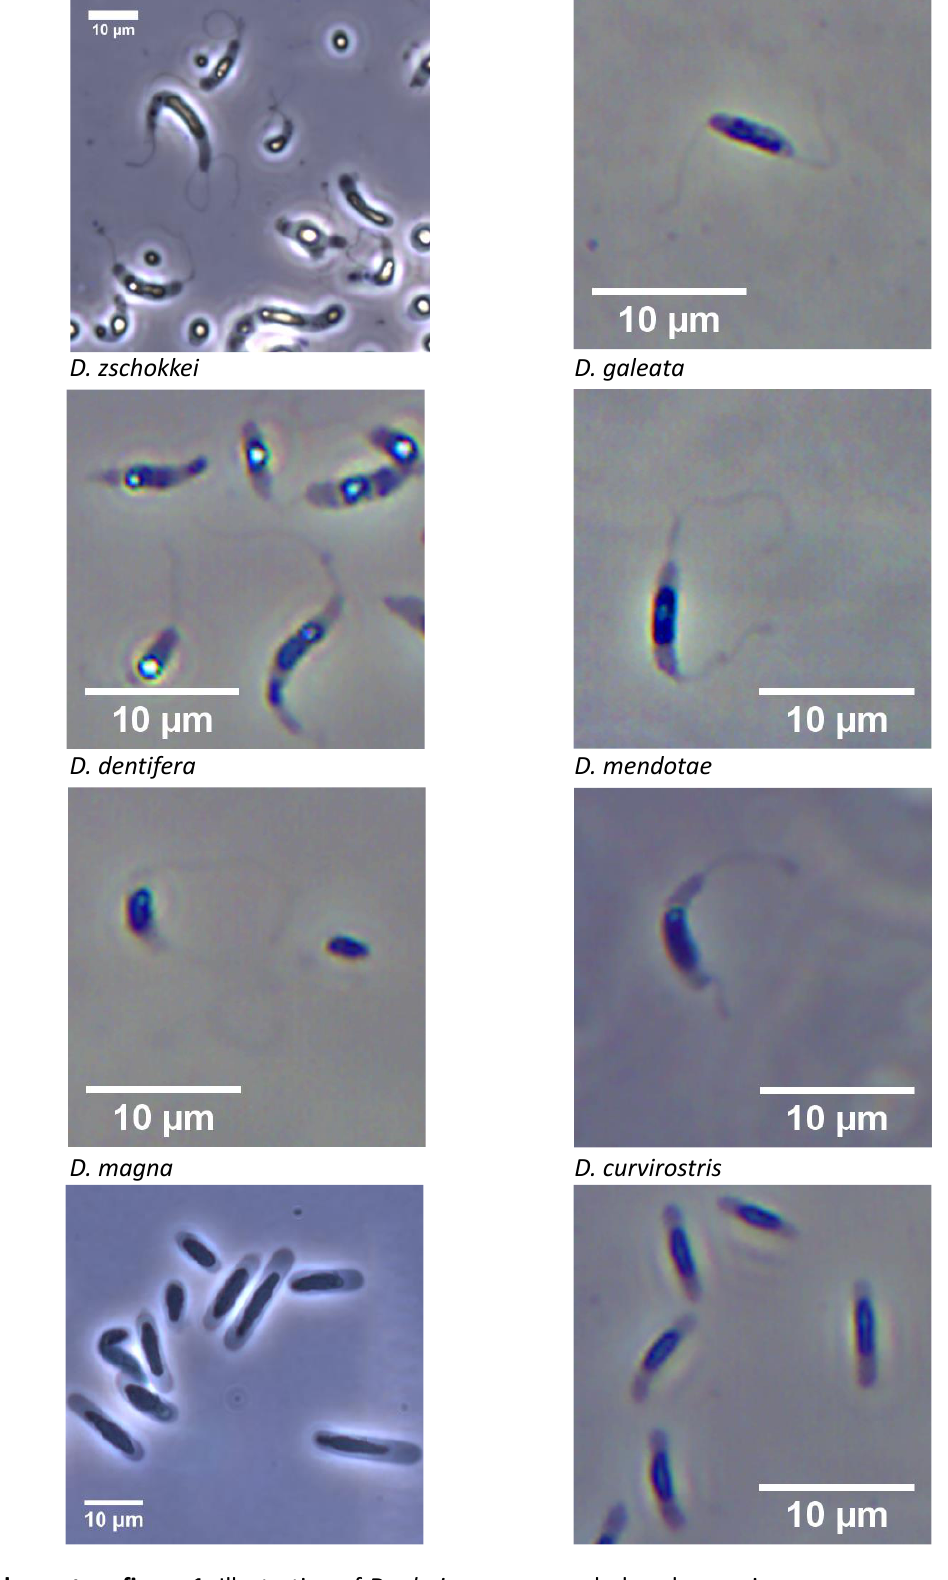
Supplementary figure 1: Illustration of Daphnia sperm morphology by